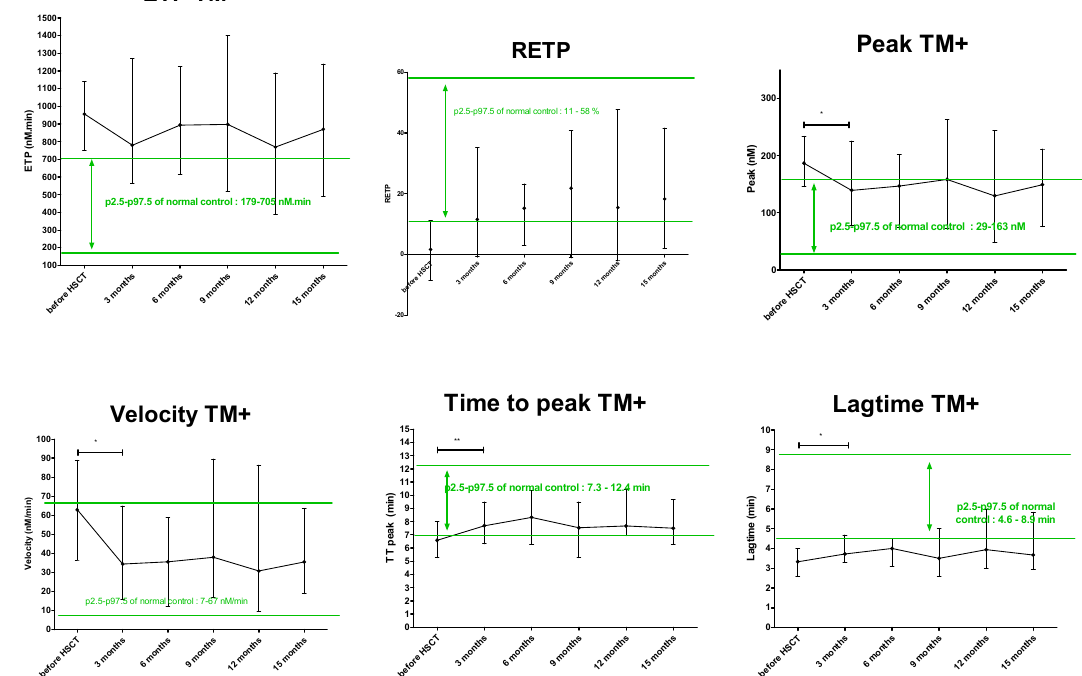
Figure 2. Modification of TG parameters (median and range) before and after successful HSCT, with (TM+) the addition of thrombomodulin. The range p2.5–p97.5 of NC is colored in green. ETP